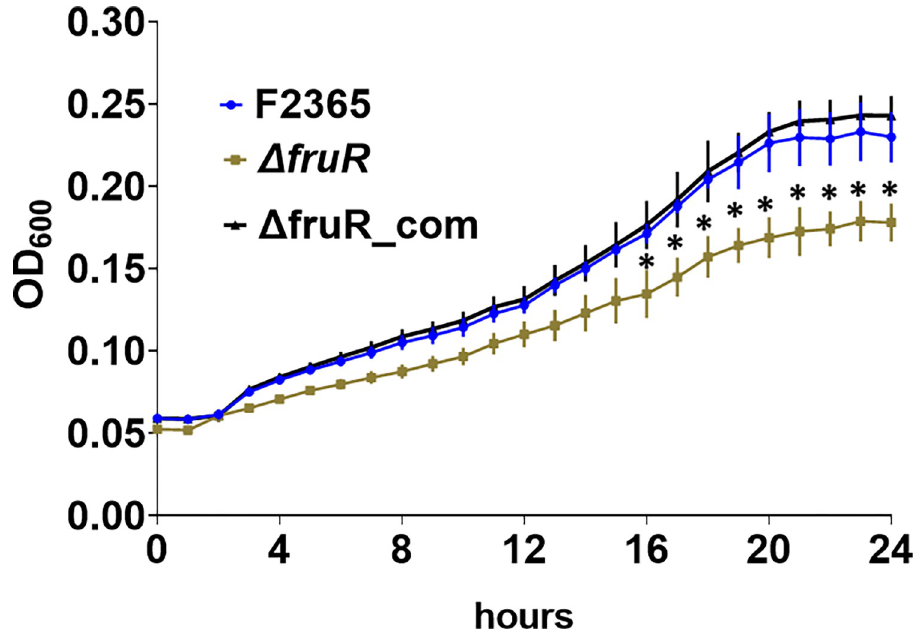
Fig 4. Growth curves of wildtype L . monocytogenes F2365 and Δ fruR in minimal medium with 50 mM glucose. Growth assays were performed in a 24-well plate, and data are averages of three independent experiments with four replicates